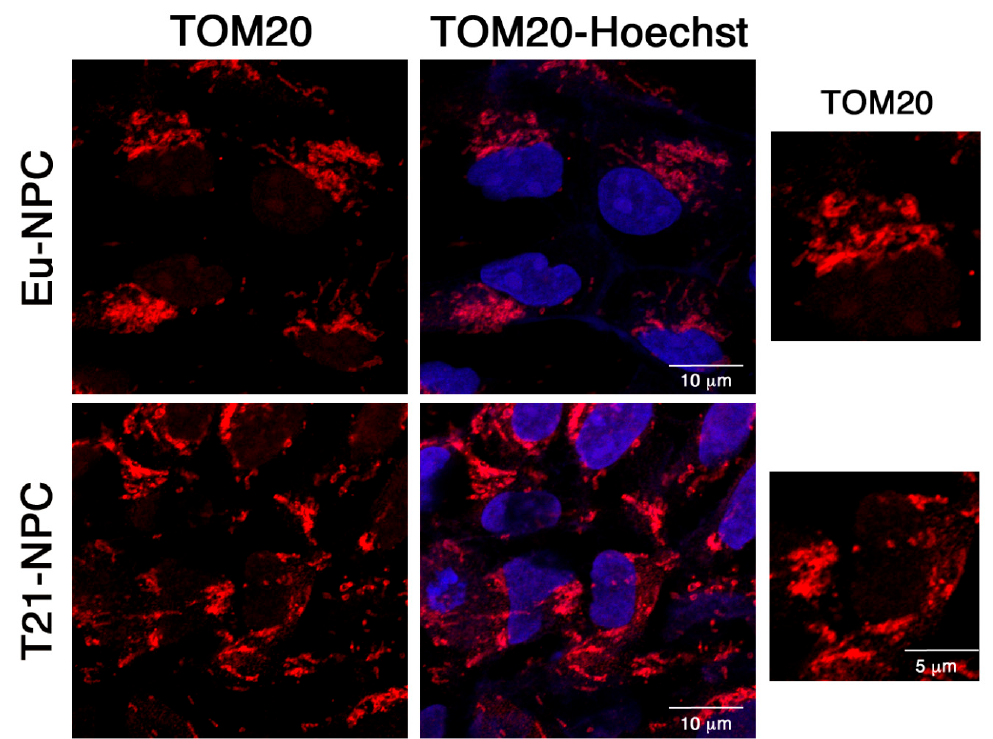
Figure 10. Organization of the mitochondrial network in euploid and trisomic NPCs at day 7 of culture in differentiation medium. Confocal microscopy representative images of the TOM20-related fluorescence of euploid and trisomic NPC clones at day 7 of neural induction. TOM20 antibody (in red) stains the outer mitochondrial membrane. Nuclei are stained with Hoechst (blue). Bar = 10 μ m. Higher magnification area from the same picture are shown on the right. Bar = 5 μ m.